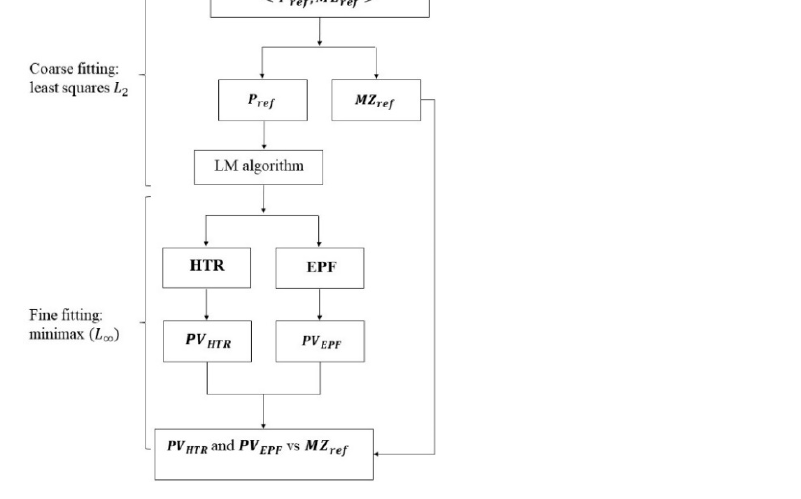
Figure 10. Comparison methodology (LM algorithm: Levenberg–Marquardt algorithm).